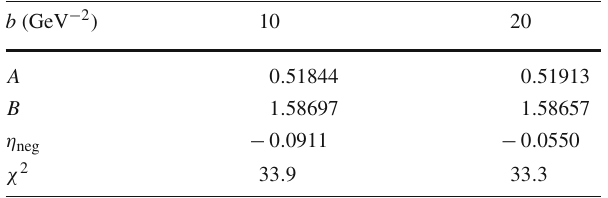
Table 2 Results of the AB fit to 51 data points with x < 0 . 001